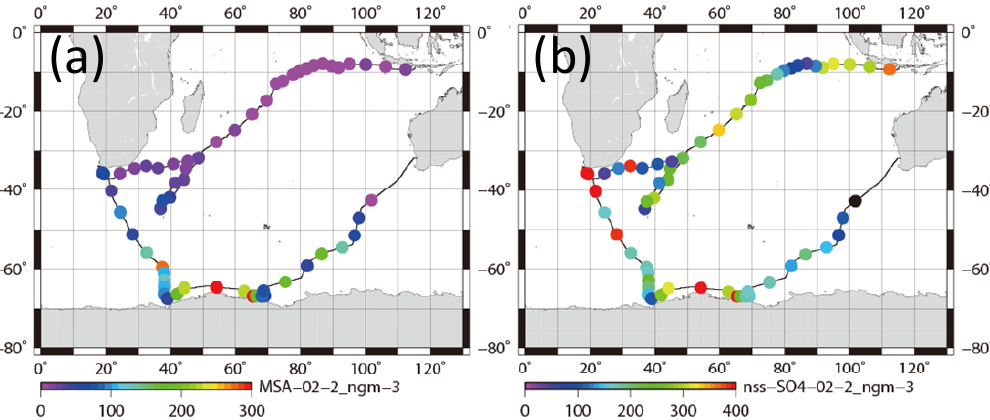
Figure 12. Horizontal variation of mass concentrations of (a) CH 3 SO −